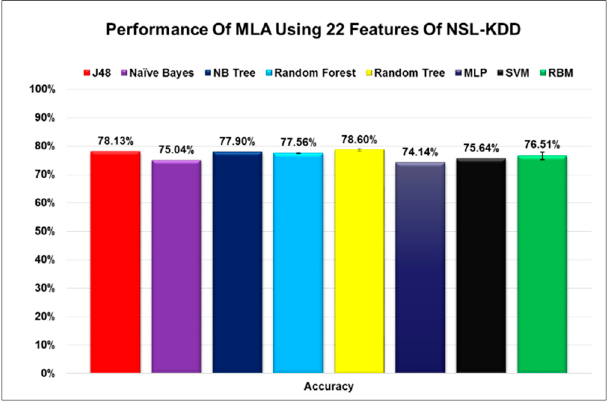
Figure 4. The performance of RBM in comparison to seven different algorithms when using 22 features.